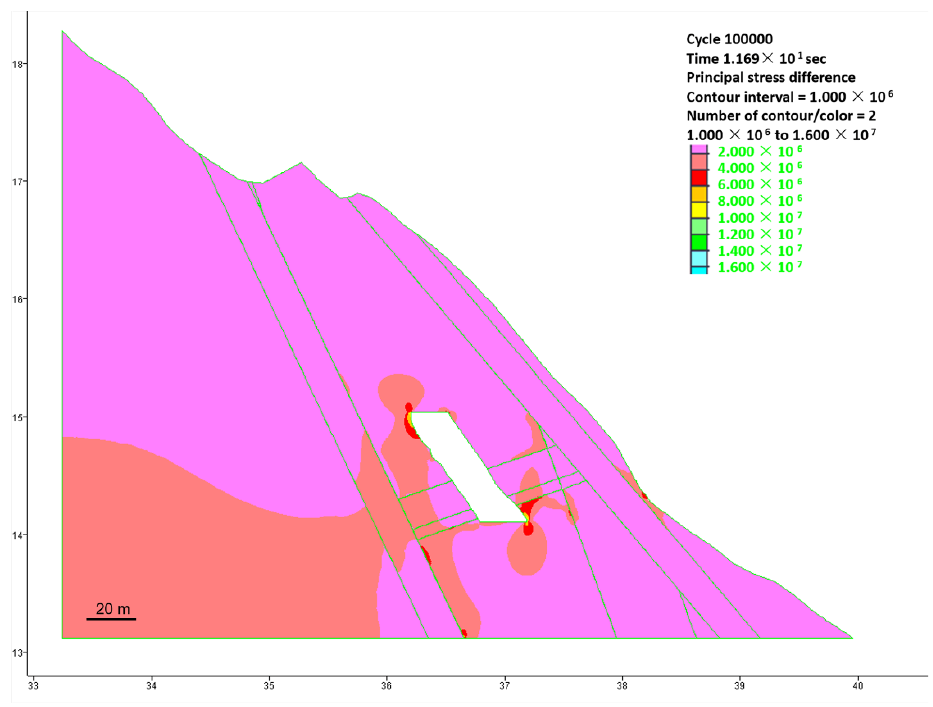
Figure 24. Deviatoric stress ( σ 1 – σ 3 ) of Section 2 calculated in Pa.